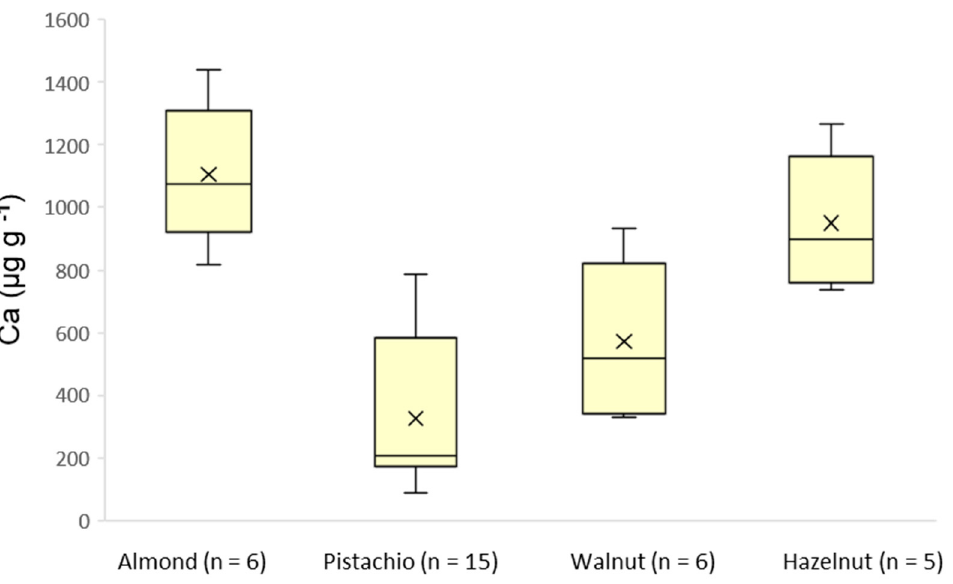
Figure 1. Box and Whisker plot for the concentrations of calcium among different nut species. The average concentration for magnesium was 1313 µ g g − 1 in almonds followed by 805 µ g g − 1 in hazelnuts and 713 µ g g − 1 in walnuts while the lowest concentration was observed in pistachios (310 µ g g − 1 ) as shown in Figure 2. The ANOVA demonstrated a p - value of 3.68 × 10 − 7 and showed a significant statistical difference among the nut samples.